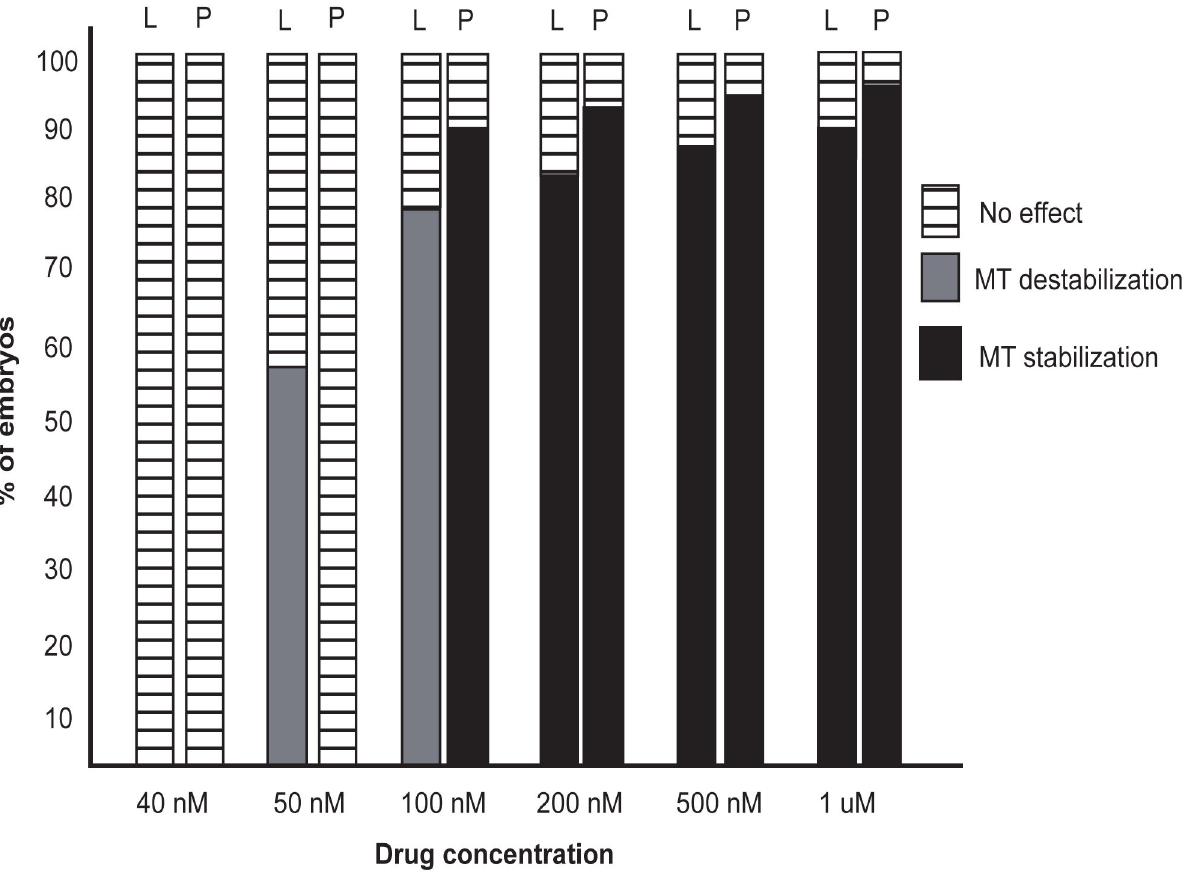
Figure 4. Dose response graph for laulimalide and paclitaxel. The graph shows the effect of various concentrations of drugs tested. n≥6 for each concentration used. L = laulimalide, P = paclitaxel. doi: